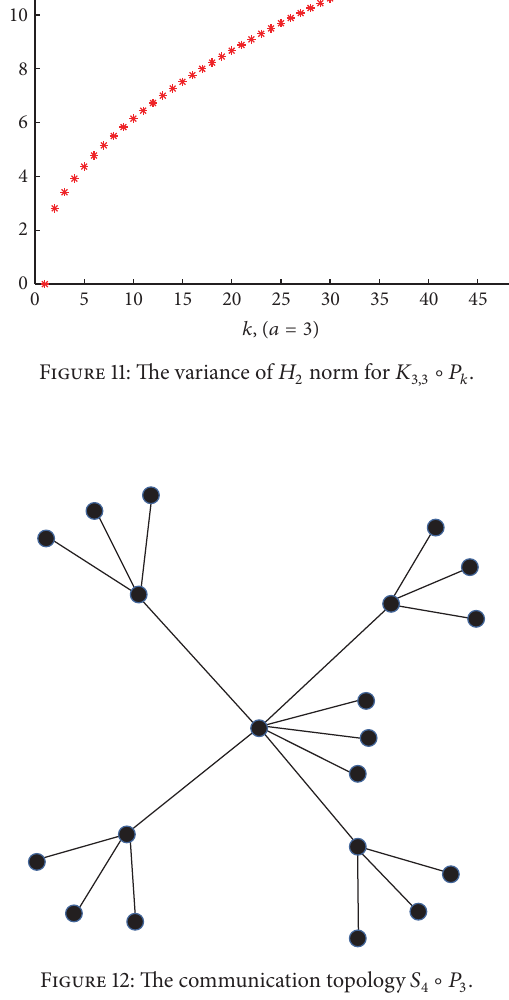
Figure 12: The communication topology 𝑆 4 ∘ 𝑃 3